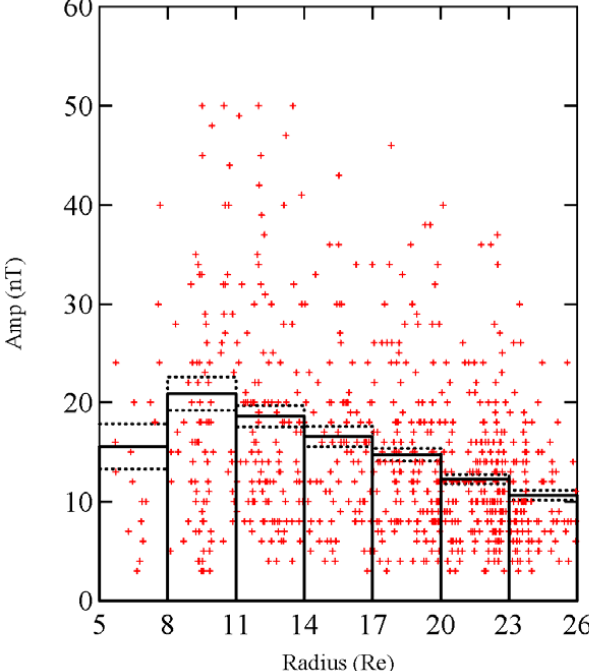
Fig. 10. Distribution of Bn perturbation amplitudes for all FTEs as function of radius. Red bars show the mean value for each bin. The dashed horizontal bars show the standard errors on the means ( σ / n 1 / 2 ) for each